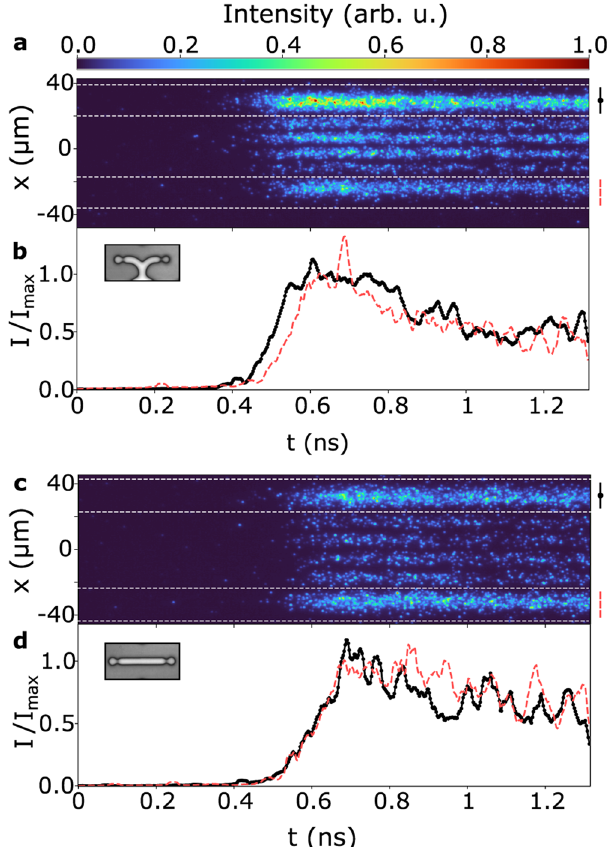
Fig. 5 Time delay in condensation under imbalanced optical pumping. a Streak camera image of the Y-coupler condensate under single-site illumination. b The spatially integrated intensity of the streak camera image regions marked by the white-dashed lines, where the condensates are located. The black line corresponds to the optically pumped condensate. A clear delay in intensity build up is apparent in both fi gures. Both intensities are normalized to the average of the 50 maximum values. c , d The same measurement, as in ( a , b ) for a condensation in the direct coupler structure. For the determination of the delay and populations imbalance, the values are ensemble averaged over 38 pulses for the direct coupler and 99 pulses for the Y-coupler. The reason for the difference in pulse numbers is the necessity of postselection due to the formation